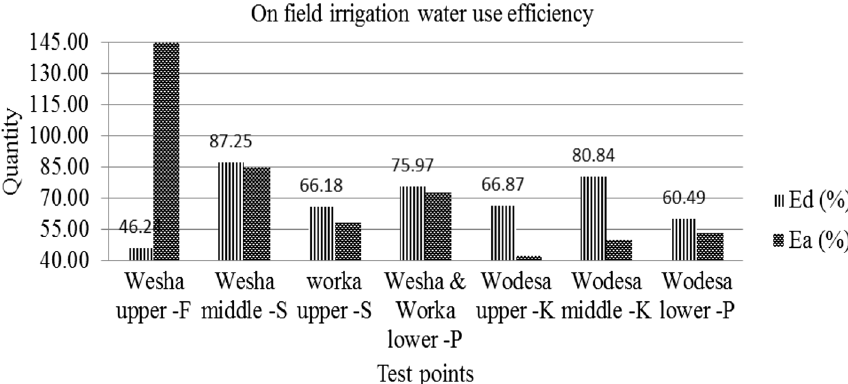
Fig. 4 Traditional surface irrigation water use efficiency in study area. Note F fruit, S sugarcane, P potato, K khat, Ed distribution efficiency, Ea application